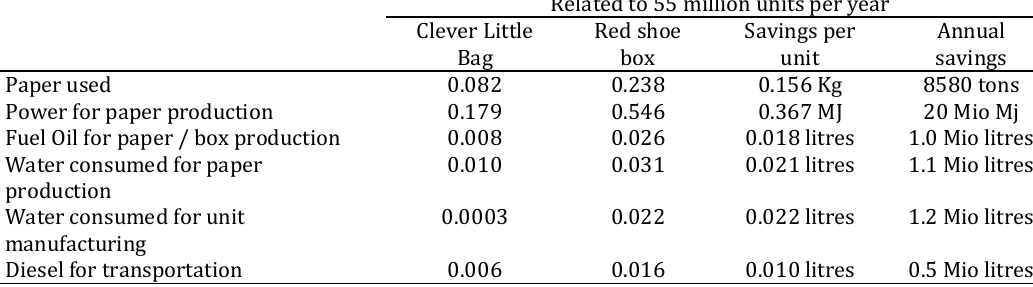
Table 1: Potential savings Clever little bag to standard red shoe